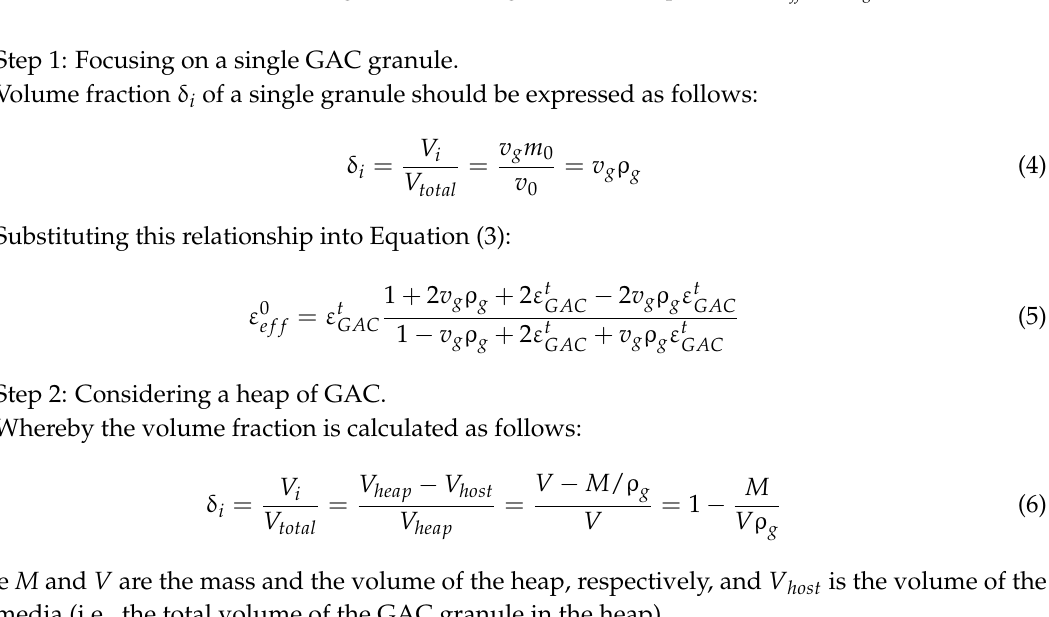
Figure 1. Schematic diagram for deriving the relationship between ε eff and v g .